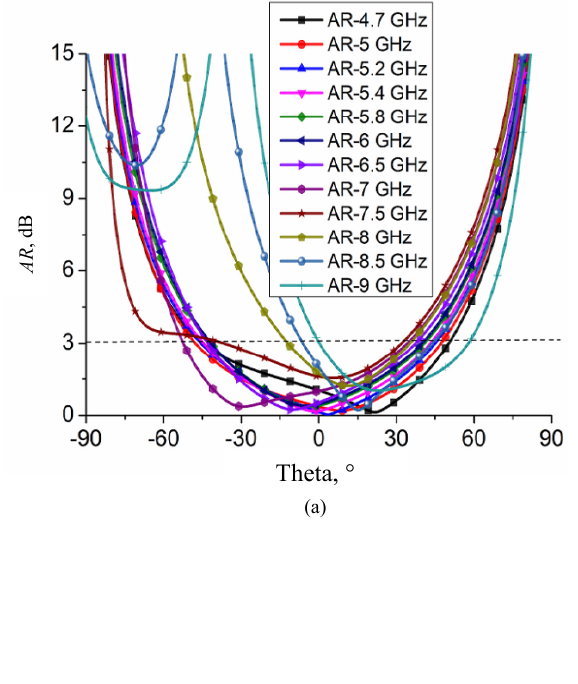
Fig. 15. AR at ɸ = 90°: (a) LHCP in the xz -plane and (b) RHCP in the yz